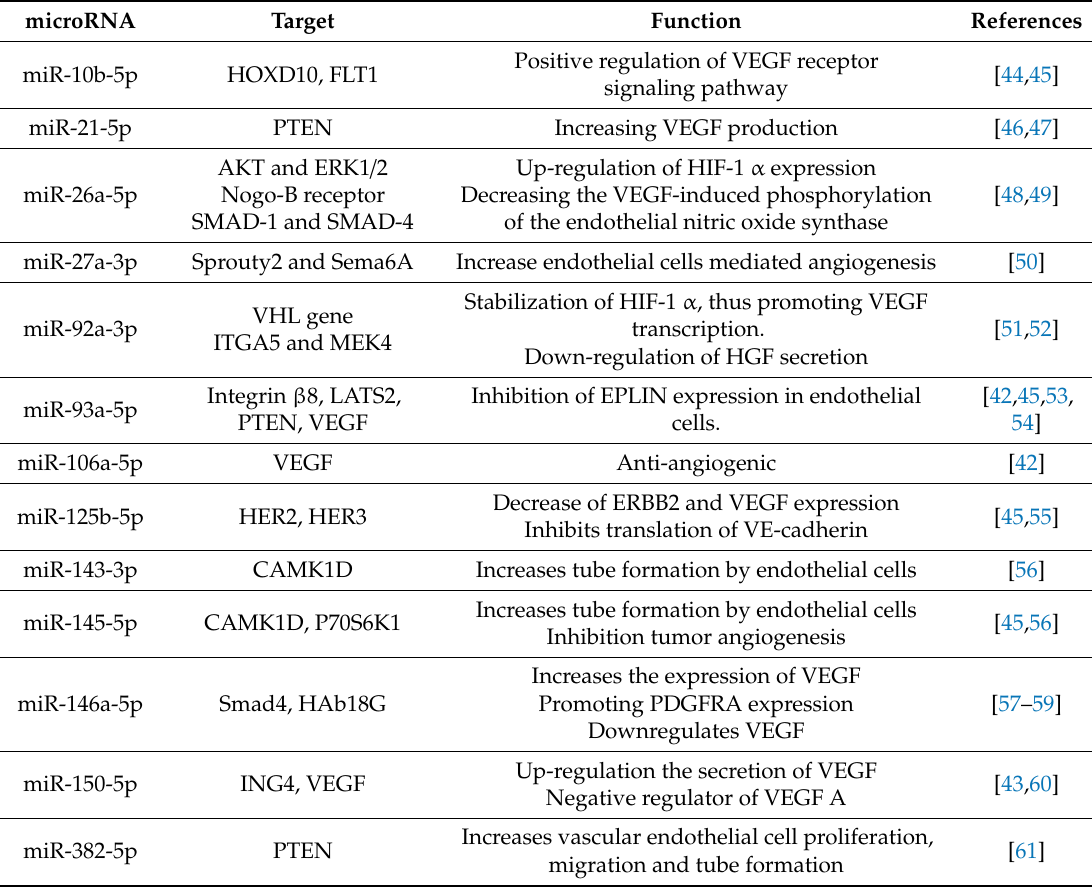
Table 1. miRNA identified in OS-derived EVs, specific targets and function in angiogenesis. microRNA